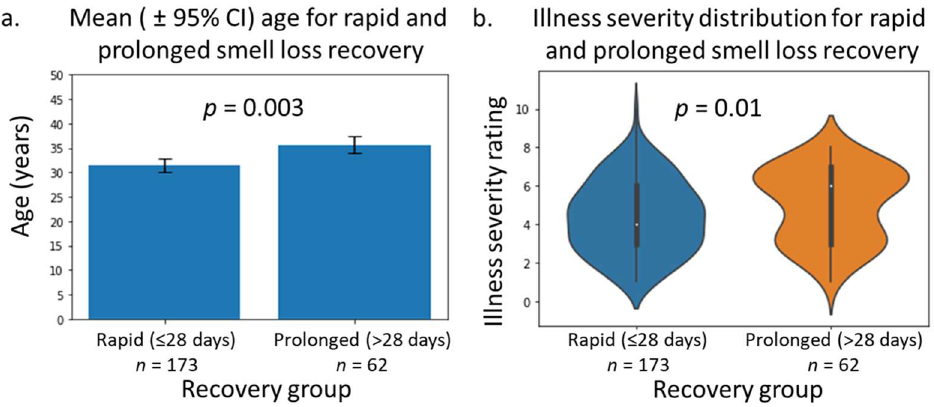
Table 1. Comparison of short (≤28 days) and long (>28 days) smell loss.